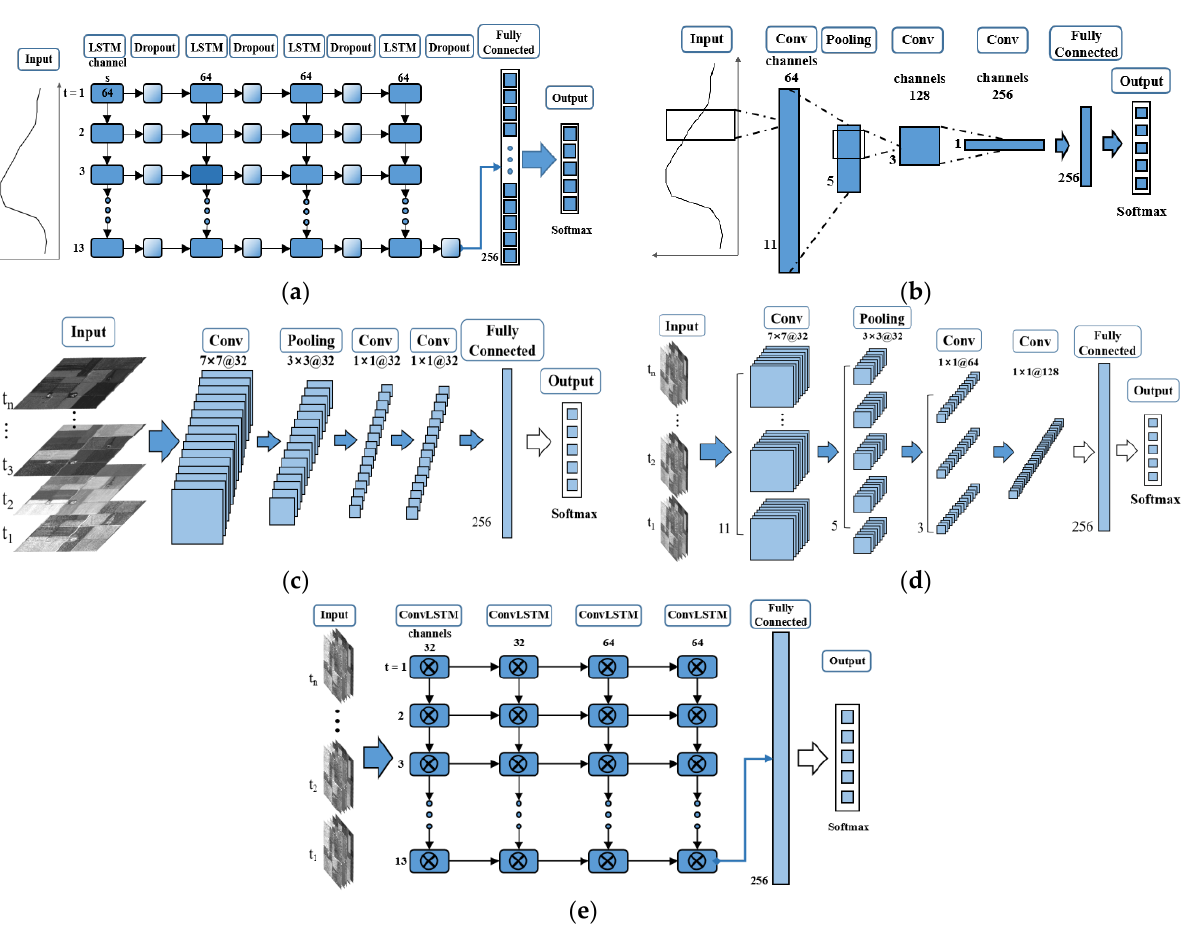
Figure 4. Architectures of ( a ) LSTM, ( b ) 1D-CNN, ( c ) 2D-CNN, ( d ) 3D-CNN, and ( e ) ConvLSTM2D.